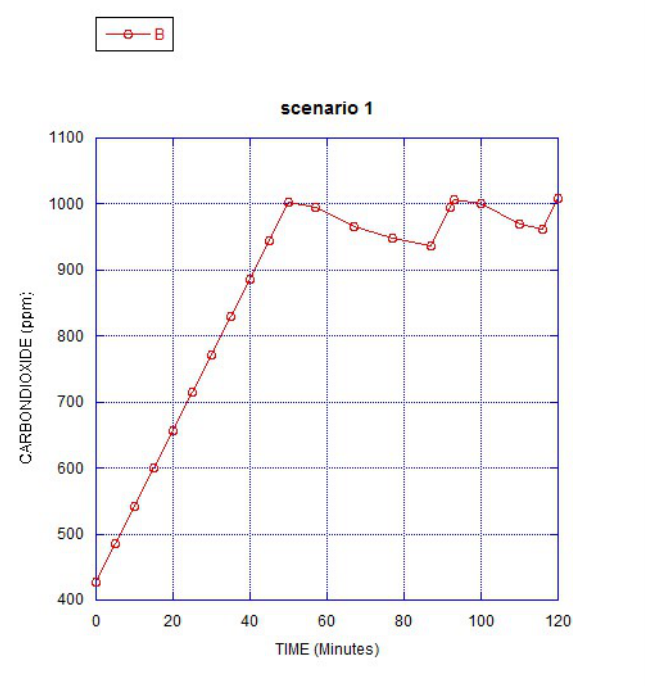
Figure 5. Simulating an operation of a ventilation fan at a threshold of 1000 ppm.